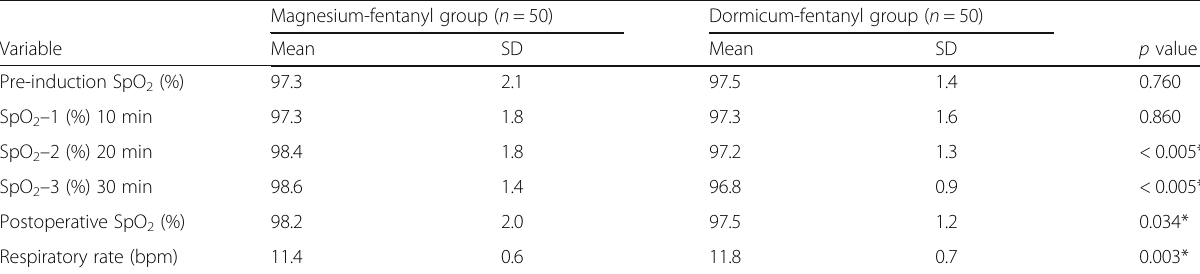
Table 4 Changes in arterial oxygen saturation and respiratory rate in both study groups Magnesium-fentanyl group ( n = 50)